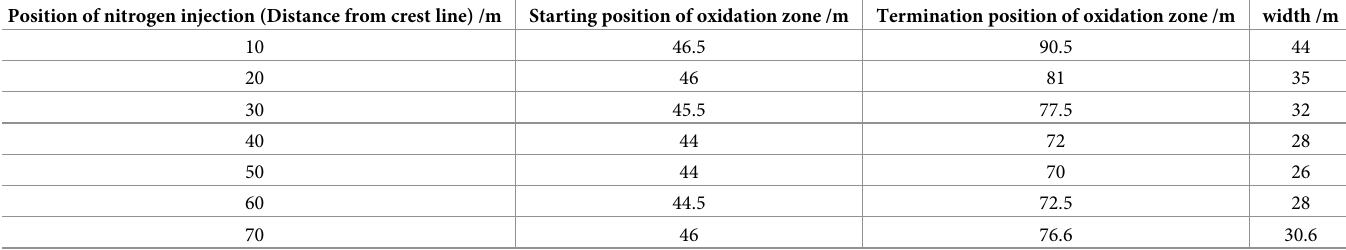
Table 1. Distribution of oxidized spontaneous combustion zone in goaf with different nitrogen injection position. Position of nitrogen injection (Distance from crest line) /m